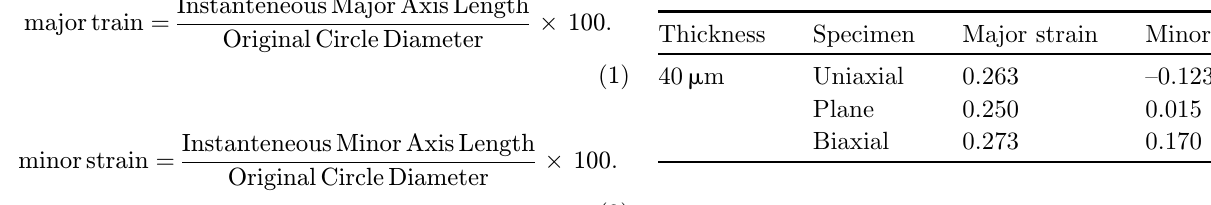
Fig. 2. Micro-formed alpha brass ultra-thin foil. Table 2. Maximum in-plane and minimum in-plane principal strain values from the physical experimentation.